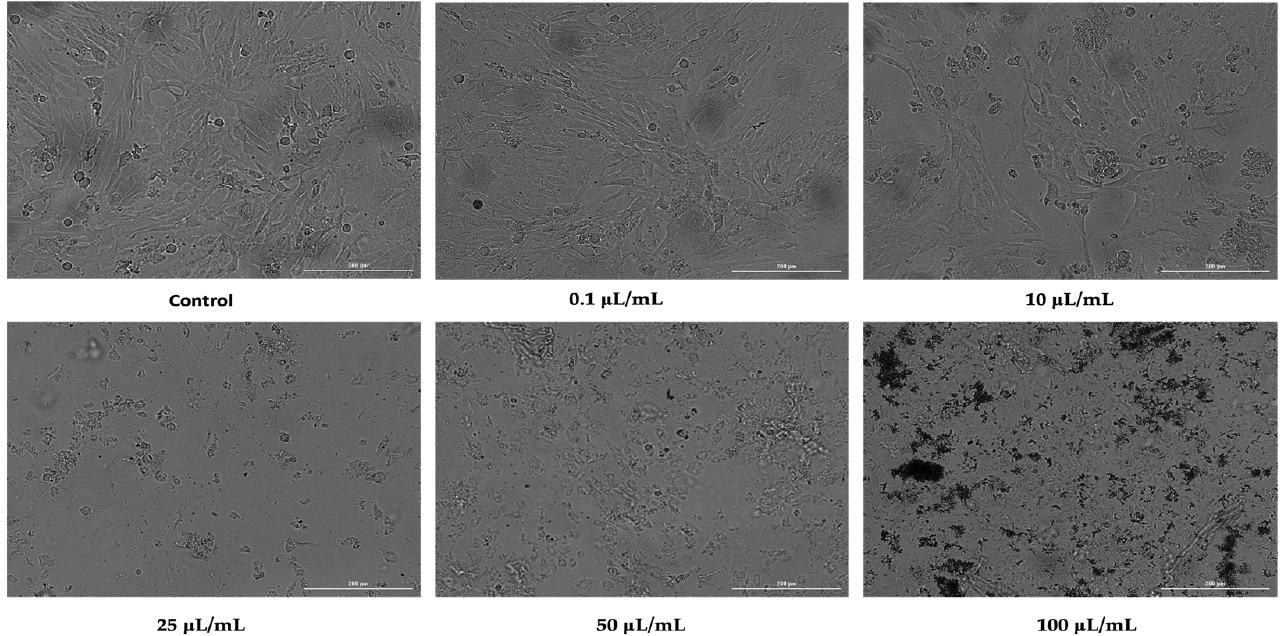
Figure 3. Morphology and confluence of hepatocytes (HepaRG) following 24 h treatment with nicotine at 0.1, 10, 25, 50, and 100 µ L/mL. The scale bars indicate 200 µ m.